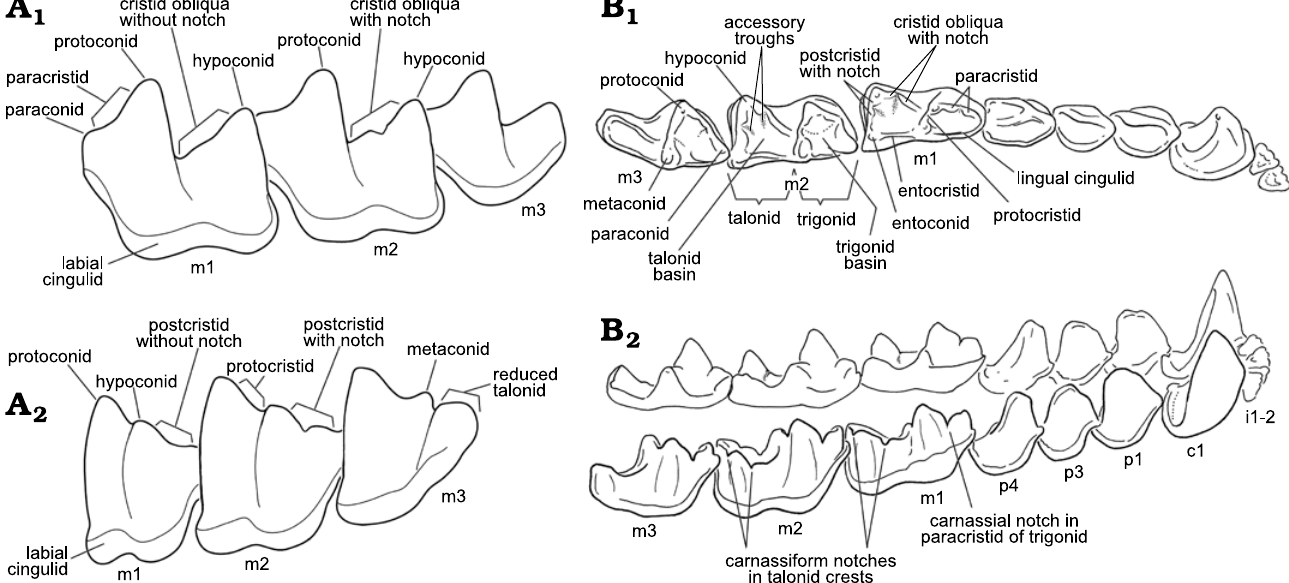
Fig. 1. Dental terminology of bat teeth used in this paper emphasizing the appearance of carnassiform notches in the lower molars. A . Lower molars in an- terolabial (A 1 ) and posterolabial (A 2 ) views. B . Example bat ( Glyphonycteris sylvestris Thomas, 1896); B 1 , left lower toothrow with strong carnassiform notches on the talonid crests of the molars, in occlusal view (note also deep carnassial notch in paracristids); B 2 , entire mandibular dentition (both right and left toothrows) as seen from the right side of the mandible. Not to